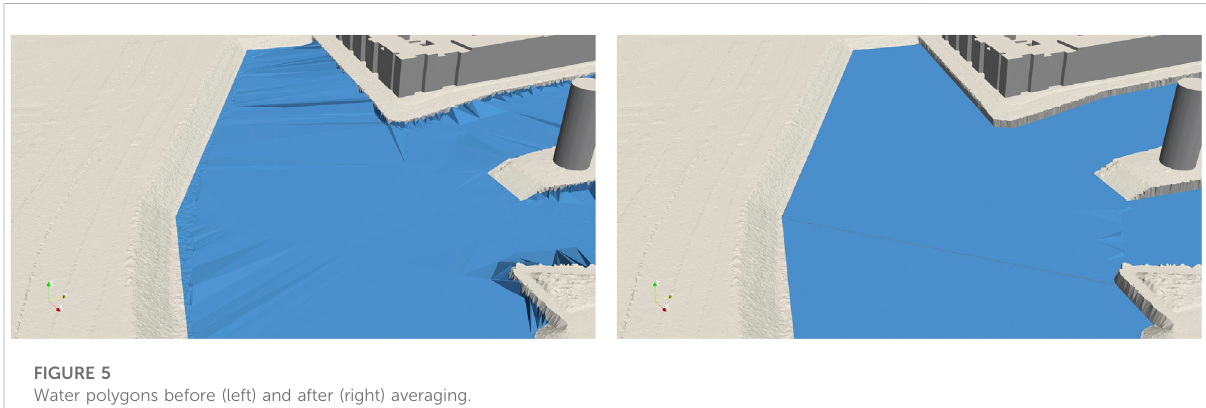
FIGURE 5 Water polygons before (left) and after (right) averaging.